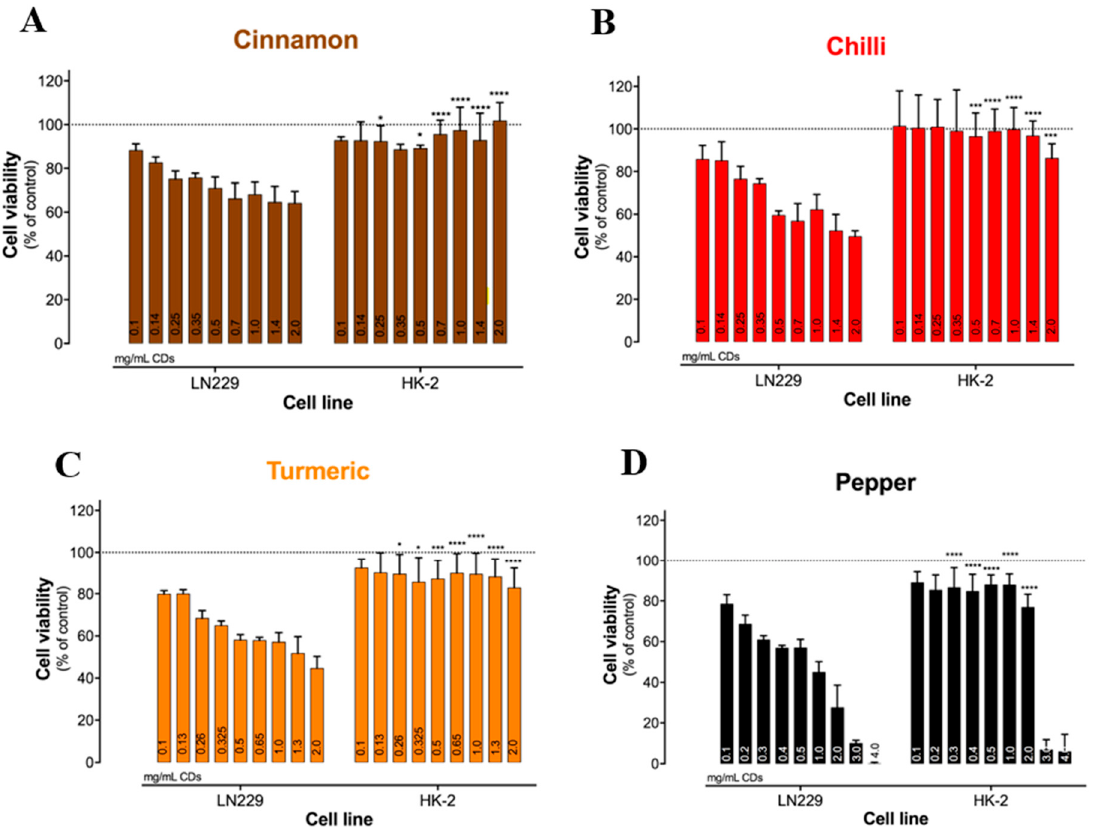
Figure 3. Cell viability evaluation in two different types of cells (cancerous LN229 cells and normal HK-2 cells) after a 24 h incubation with increasing concentrations of: ( A ) cinnamon, ( B ) red chili, ( C ) turmeric and ( D ) black pepper carbon dots. Represented results are mean ± SD of at least three independent experiments. * p < 0.05, *** p < 0.001 and **** p < 0.0001 are for statistical significance of differences between the effect of the same concentration of spice-based carbon dots in other cell line (LN229). Adapted from ref.